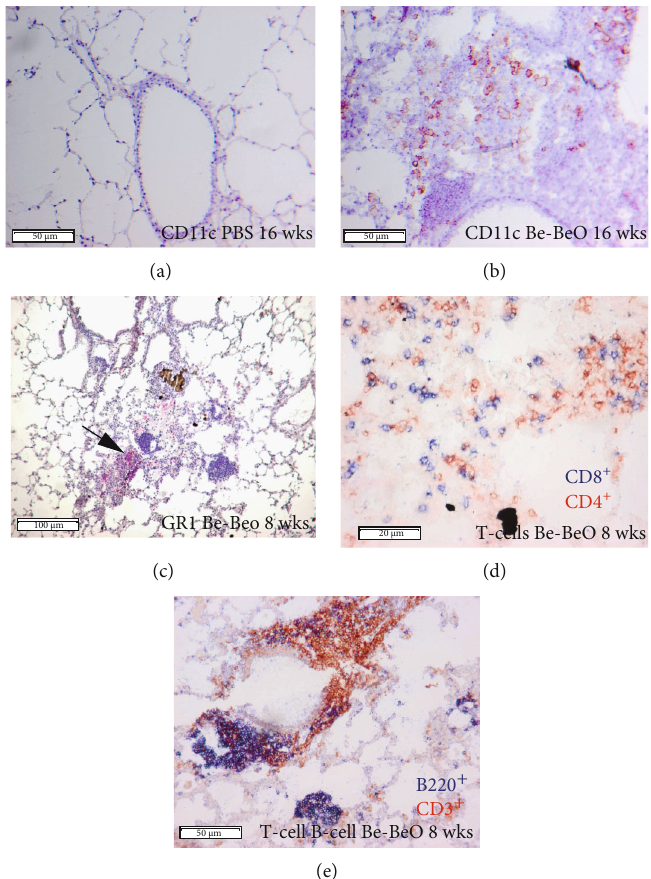
Figure 3: Characterization of in fl ammatory structures in the CBD lungs. Immunohistochemistry of lung sections, together with hematoxylin and eosin (H&E) staining. (a) Limited numbers of CD11c + cells in the lungs of PBS control mice. (b) Abundant presence of CD11c + cells forming granuloma-like structures in CBD mice 16 weeks after initial exposure Be BeO (c) Gr-1 + granulocytic in fl ammation in CBD mice 8 weeks after initial exposure. (d) Di ff use and dense in fi ltration of CD4 + (red) and CD8 + (blue) T cells. (e) Perivascular focal dense in fi ltration, re fl ecting TLS, consisting of B220 + B cells (blue) and CD3 + T cells (red) in the lungs of CBD mice at 8 weeks. Data are representative for 5-7 mice analysed in each group. Bars are 20 μ m (d), 50 μ m (a, b, e), or 100 μ m